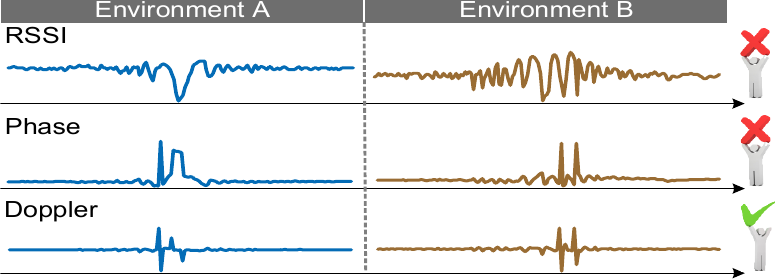
Figure 3. RSSI, phase and Doppler analysis in different